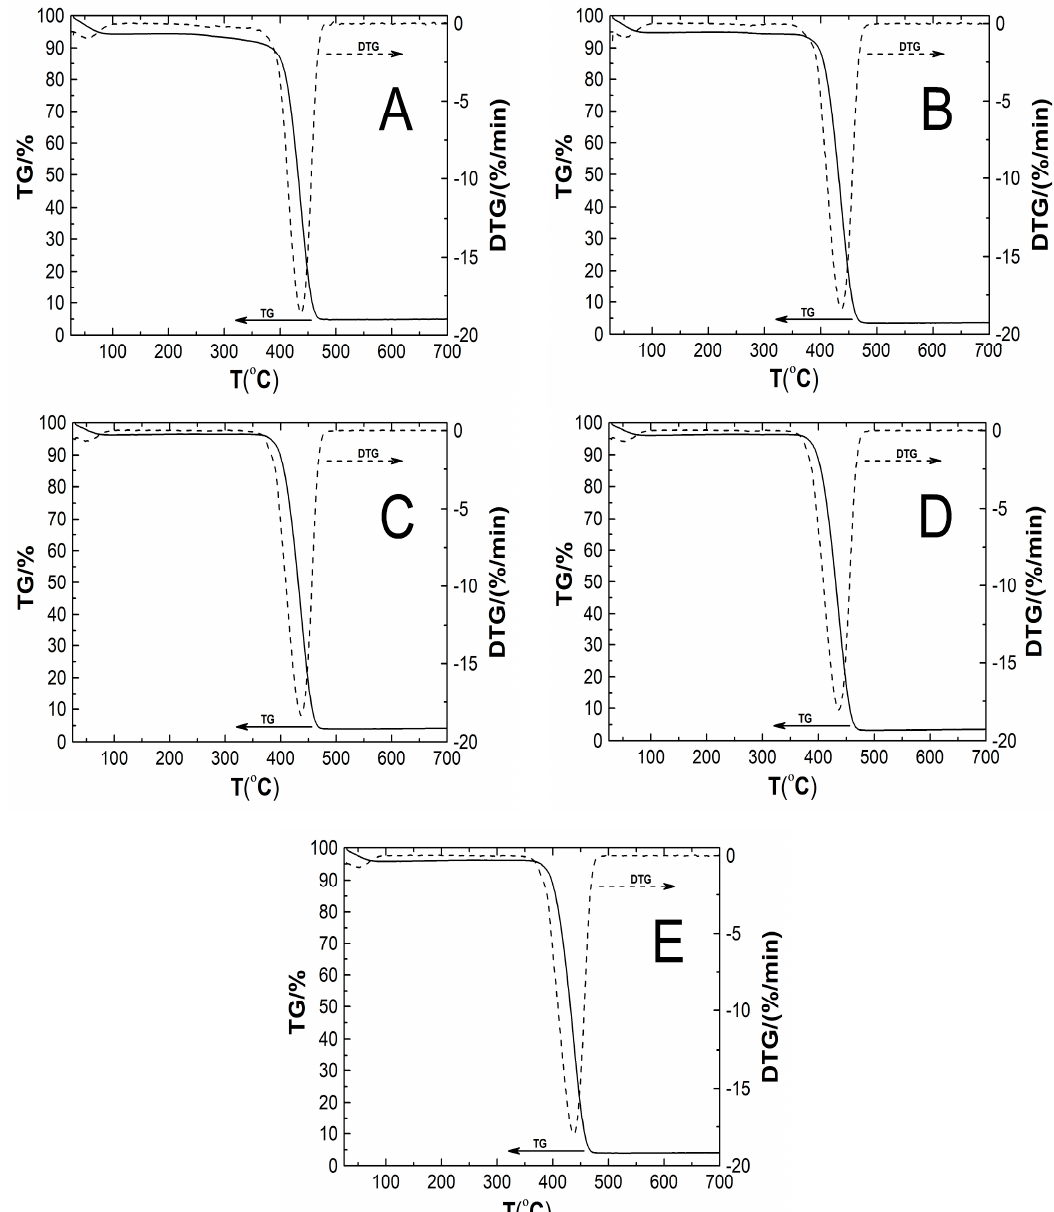
Figure 10. TG (solid line) and DTG (dash line) curves of weight loss (%) vs. temperature of polymers P1 ( A ), P5 ( B ), P3 ( C ), P4 ( D ), and P5 ( E ) obtained at heating rate of 10 ° C min − 1 in a nitrogen atmosphere at 50 mL ⋅ min − 1 .